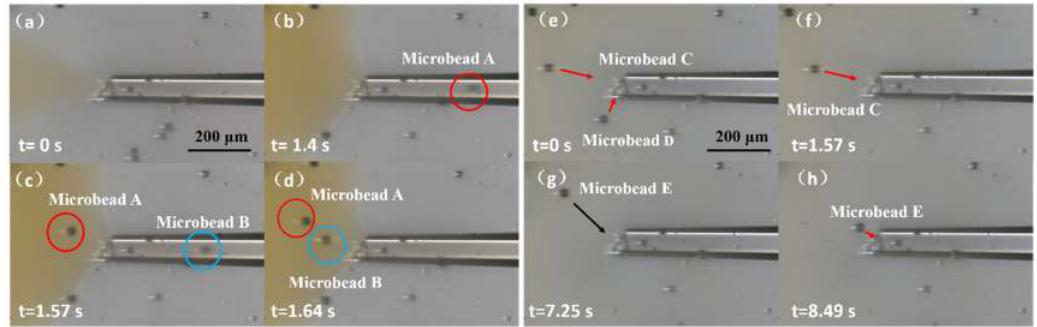
Figure 11. ( a – d ) Microbead ejection from the nozzle. ( e – h ) Microbead absorption on a glass capillary.